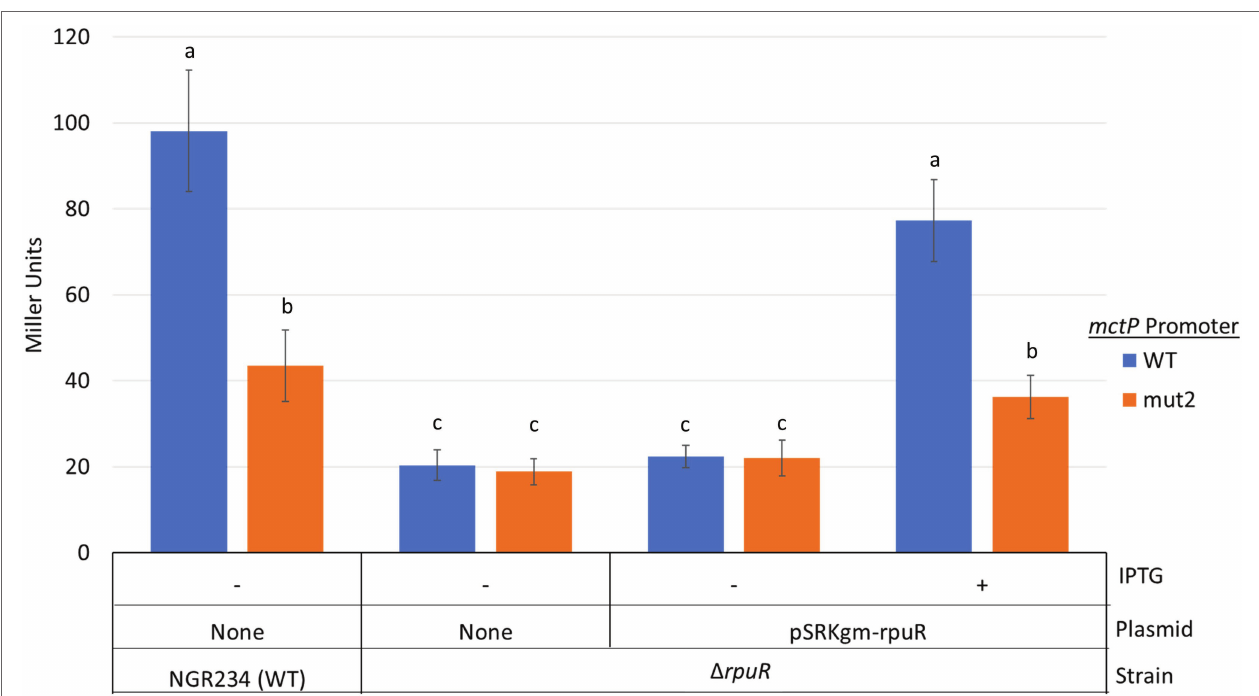
FIGURE 4 | Activity of in-cis transcriptional fusions of the of the NGR_RS10970- mctP operon promoter, and its mut2 derivative, in various genetic backgrounds under pyruvate-utilizing conditions. Miller units are expressed as means ± Standard deviations (error bars) of results from at least three independent experiments. Means accompanied by the same letter are not significantly different (p < 0.05). NGR234, parent strain; Δ rpuR, rpuR deleted strain; +, induction of rpuR expression from plasmid pSRKgm with 100 mm IPTG. Cultures were inoculated to a A 620 of 0.1 in minimal medium supplemented with pyruvate and incubated at 150 rpm and 30 ° C for 12